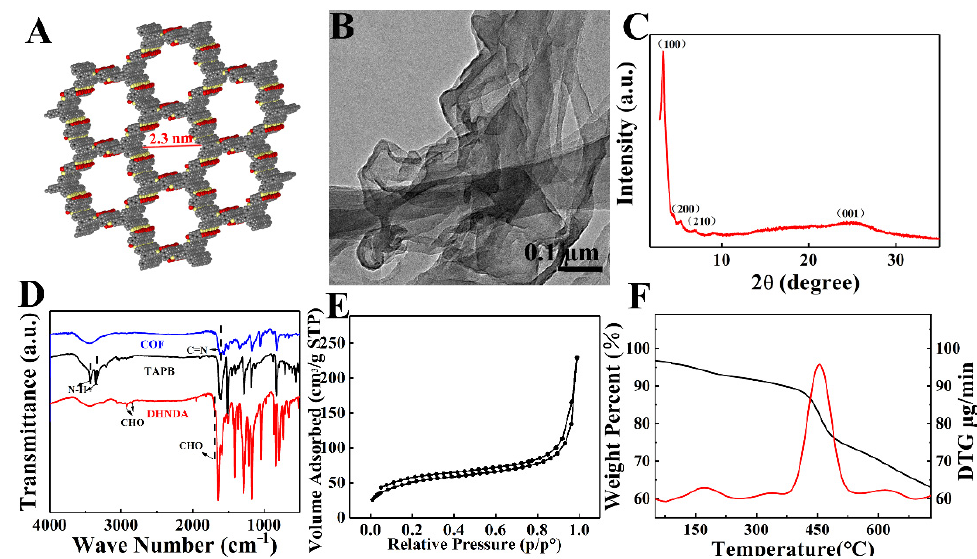
Figure 1. ( A ) The 3D structure of COF TD . ( B ) TEM image of COF TD . ( C ) XRD pattern of COF TD . ( D ) FTIR of COF TD , TAPB and DHNDA. ( E ) N 2 -adsorption/desorption isotherm of COF TD . ( F ) TGA curve of COF TD .